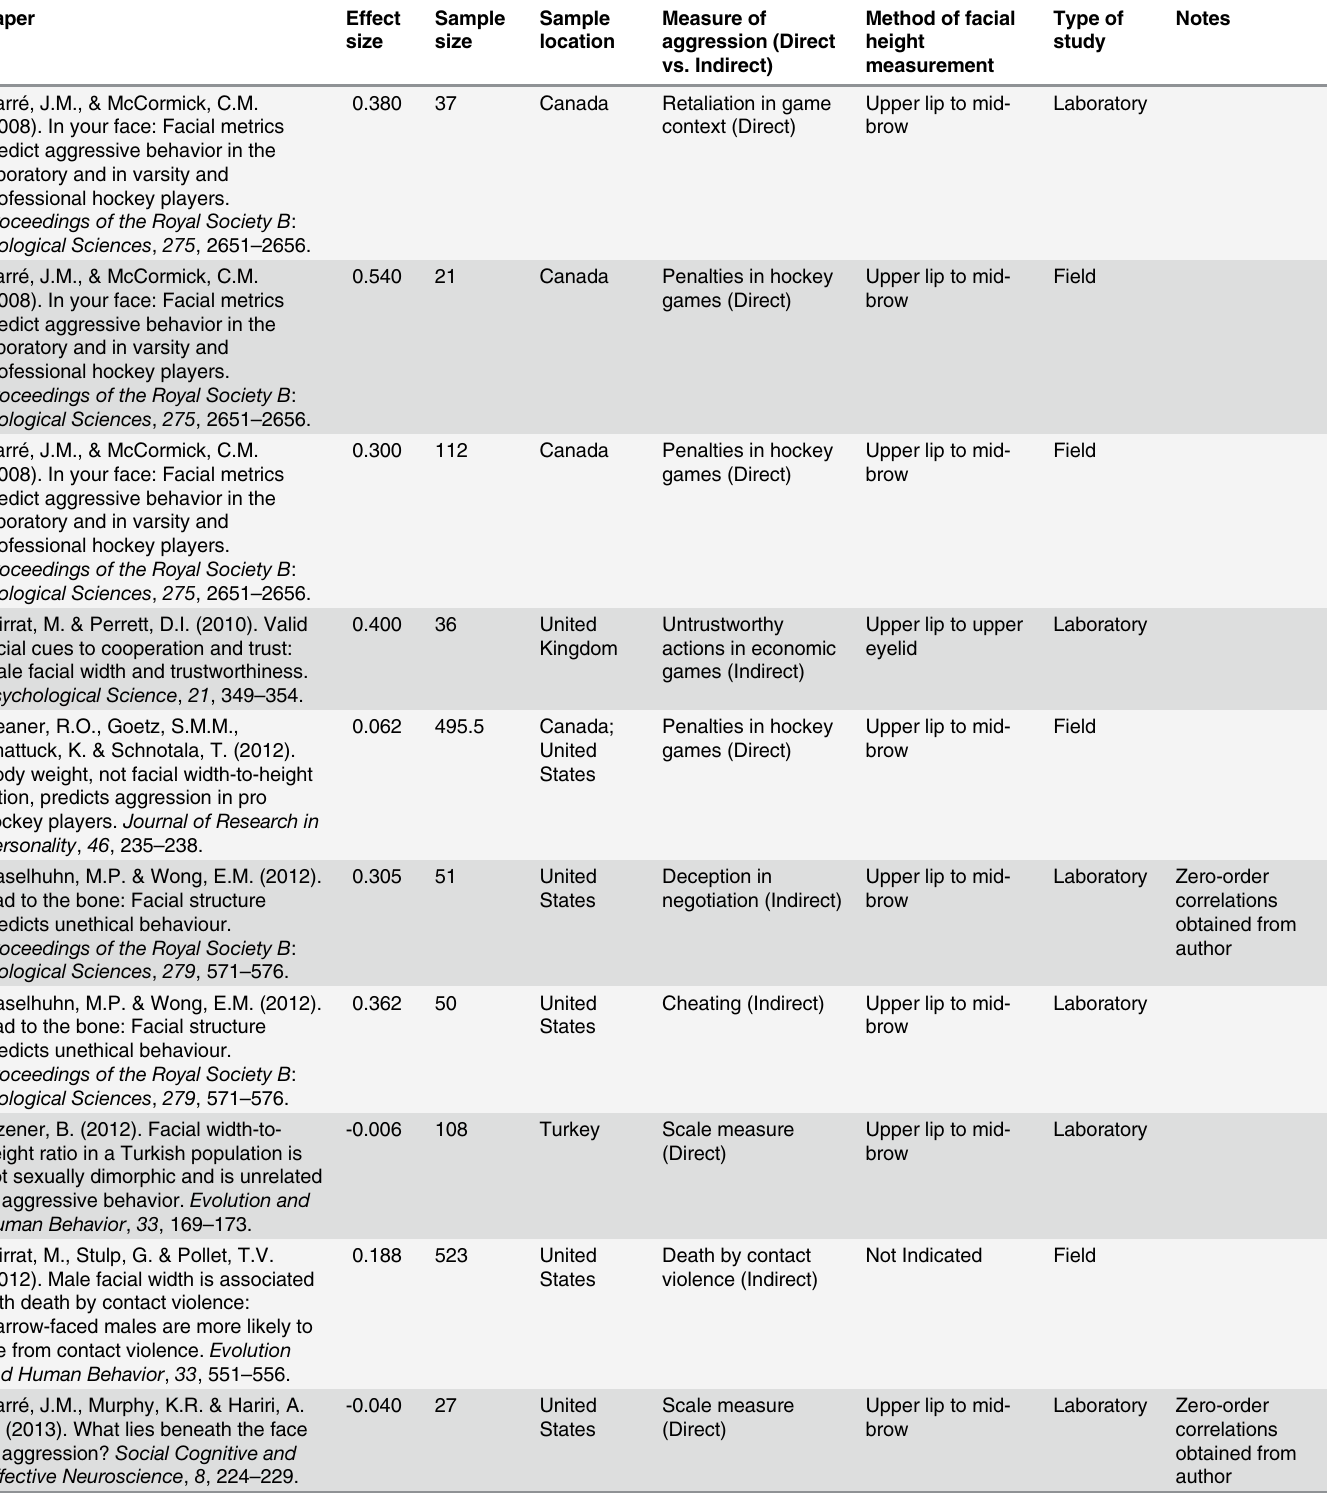
Table 1. Included